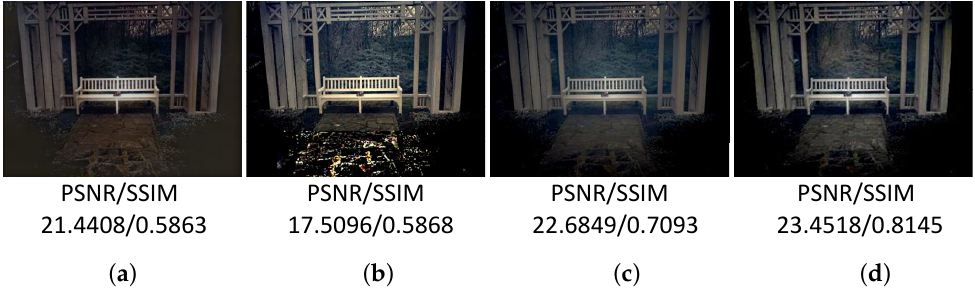
Figure 1. This is a comparison example. ( a ) The experimental result of Qu et al. [22]; ( b ) The experimental result of Li et al. [15]; ( c ) The experimental result of Zhang et al. [18]; ( d ) Our experimental